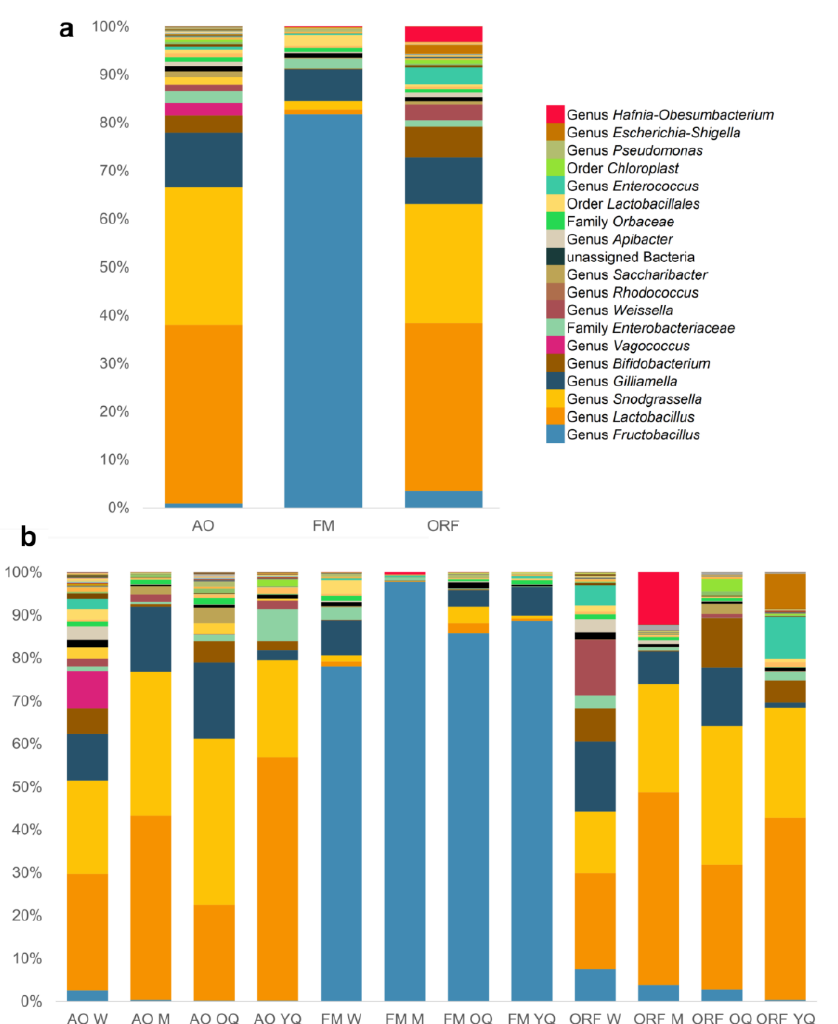
Figure 1. Relative abundance (%) of the bacterial genera found in the guts of bumblebee. ( a ) Distribution of bacterial genera within habitat; ( b ): distribution of bacterial genera for each caste within a habitat. AO: apple orchards, FM: forest meadows, ORF: oilseed rape fields, W: workers, M: males, OQ: ovipositing queens, YQ: young queens.